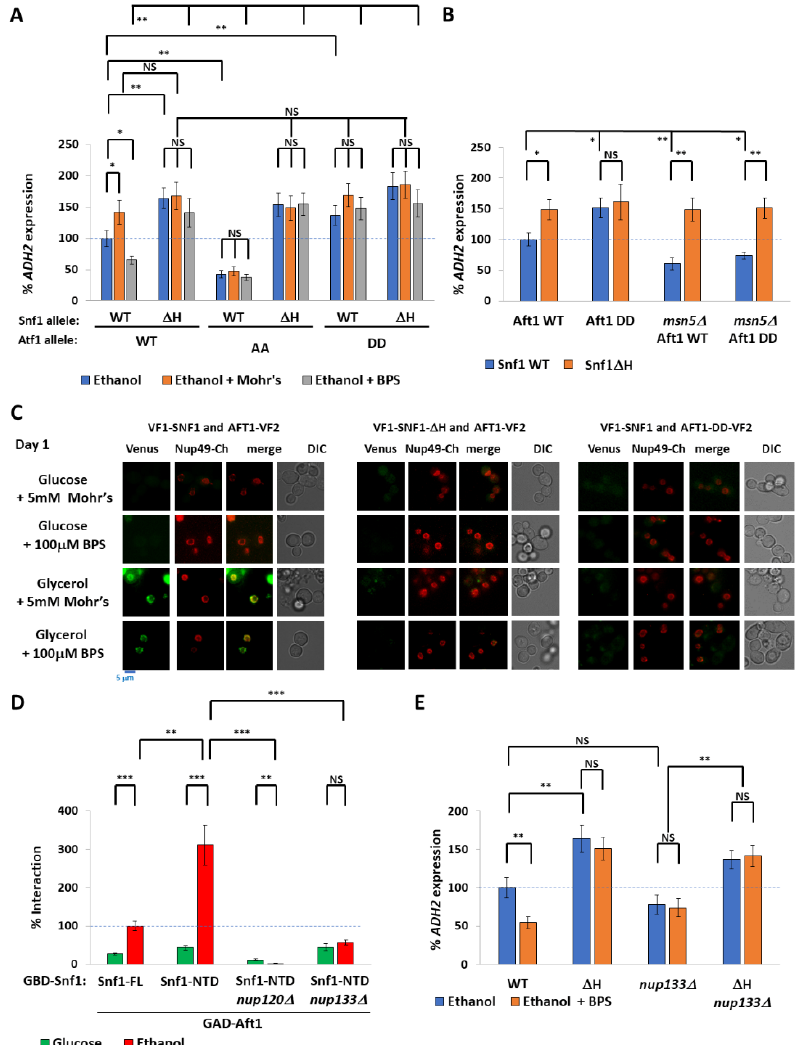
Figure 4. Nuclear Aft1 inhibits Snf1. ( A , B ) Rate of prADH2 ::LacZ expression of snf1 Δ aft1 Δ cells (and snf1 ∆ aft1 ∆ msn5 ∆ cells ( B )) expressing indicated Snf1 and Aft1 mutants from plasmids. Aft1 AA is Aft1 – S210A S224A. Aft1 DD is Aft1-S210D S224D. An amount of 100 μM BPS or 5 mM Mohr ’ s salt